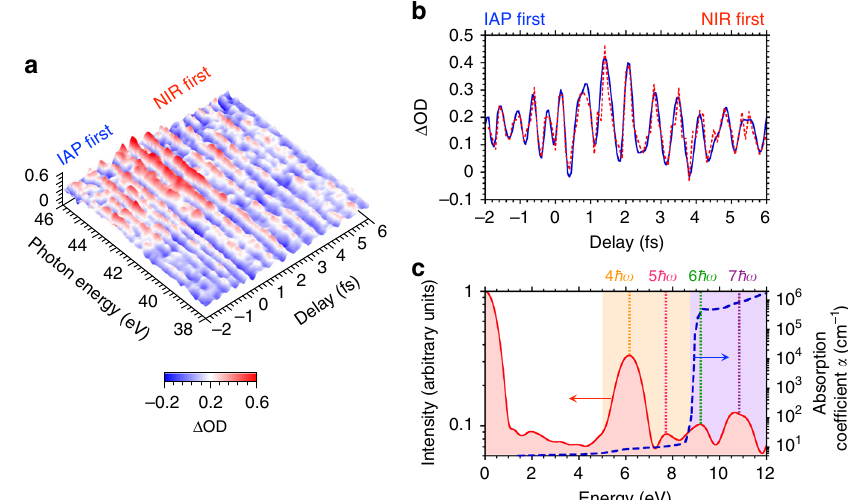
Fig. 2 Multi-petahertz interferogram and energy components in Cr:Al 2 O 3 . a Measured interferogram based on transient absorption spectroscopy. The trace shows the deviation of optical density ( Δ OD) with and without the NIR pulse as a function of the temporal delay. The trace is averaged over ten measurements. b Graph showing the integrated line pro fi le (red dashed line) for the 38 – 46 eV photon energy region in a . The blue solid line corresponds to the interpolation process line pro fi le. c Line pro fi le spectrum (red solid line and shaded area) with Fourier transformation for the temporal delay axis in b . The dotted lines correspond to the photon energies of 6.2 (4 ħ ω ), 7.7 (5 ħ ω ), 9.2 (6 ħ ω ), and 10.8 eV (7 ħ ω ). The ω is the center angular frequency of the NIR pulse. The ħ ω corresponds to 1.55 eV. The blue dashed line shows the absorption coef fi cient α from our measurement (<8.7 eV) and ref. 33 (>8.7 eV). The orange and purple shaded areas correspond to the donor-like and CB states,